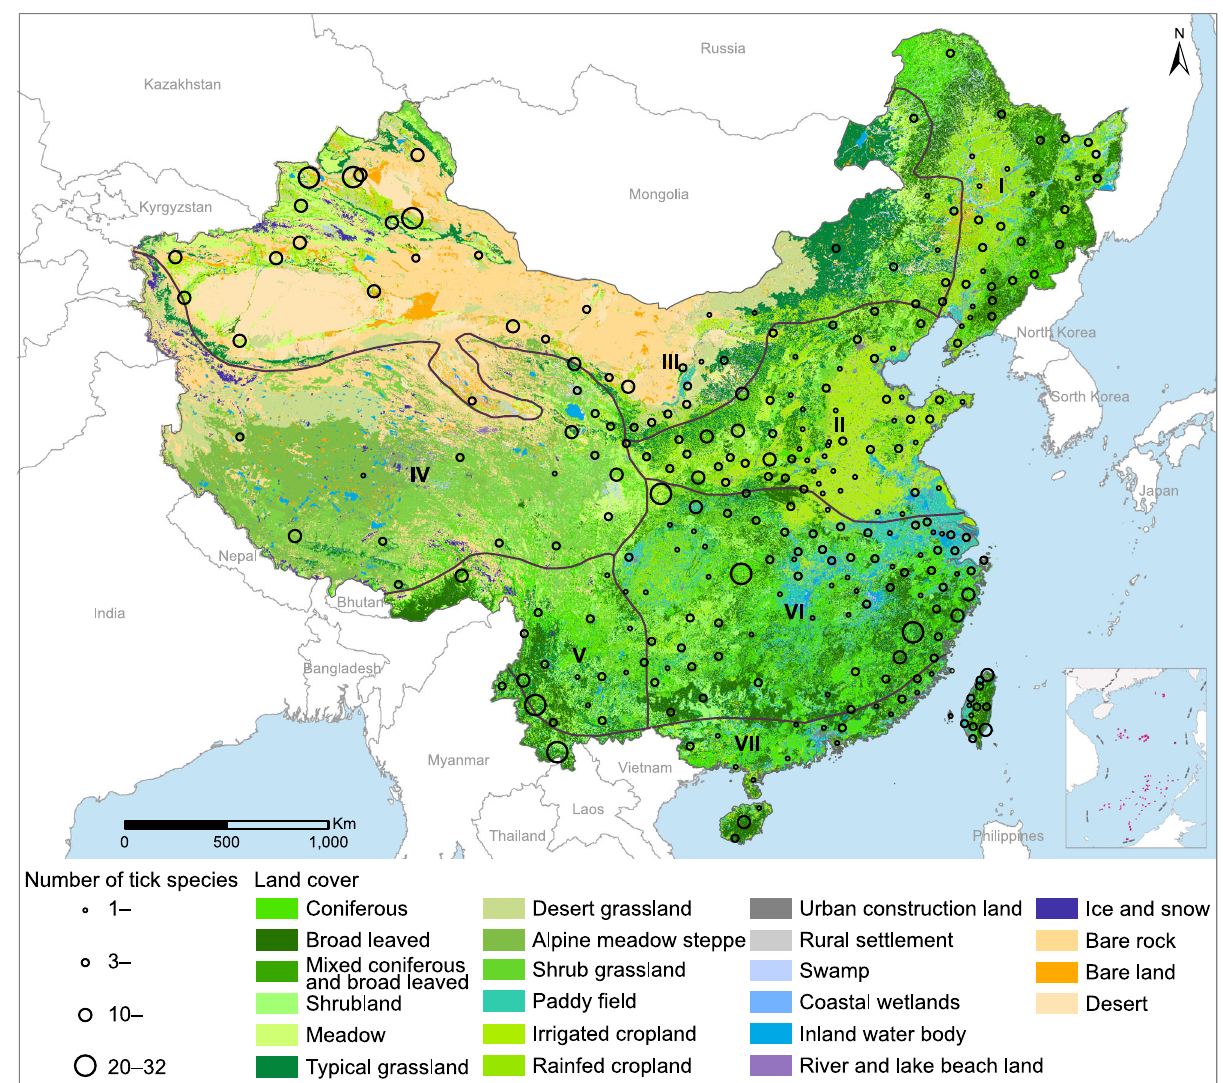
Fig. 1 Tick species richness (circles) at the prefecture level in seven biogeographic zones in mainland China from 1950 to 2018. I = Northeast district (NE), II = North China district (N), III = Inner Mongolia – Xinjiang district (IMX), IV = Qinghai – Tibet district (QT), V = Southwest district (SW), VI = Central China district (C), and VII = South China district (S). Source data are provided as a Source Data fi